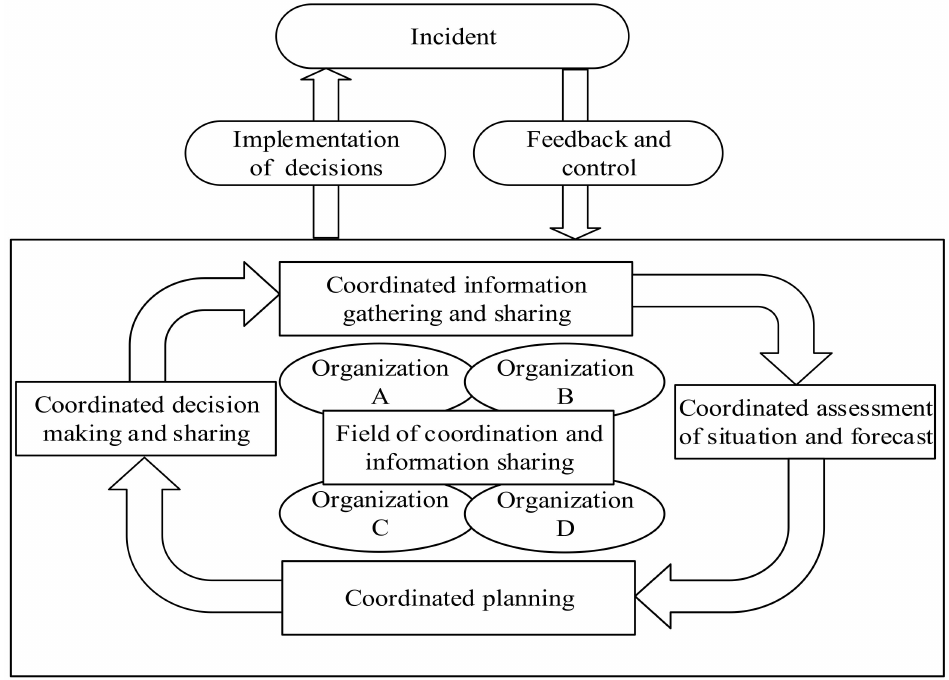
Figure 3. Circular chart for a multiple hierarchical command and control process with enhanced relevance of